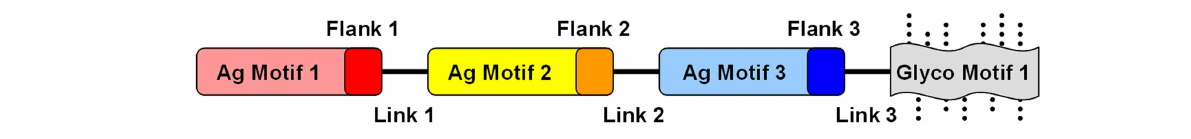
FIGURE 4 | Conceptual design of modular and combinatorial convergent vaccine immunogens . Illustrated here is an example of a convergent vaccine immunogen that integrates multiple antigen motifs ( Ag motif ) containing flanking sequences ( Flank ) optimized asT-cell epitopes, interposed by